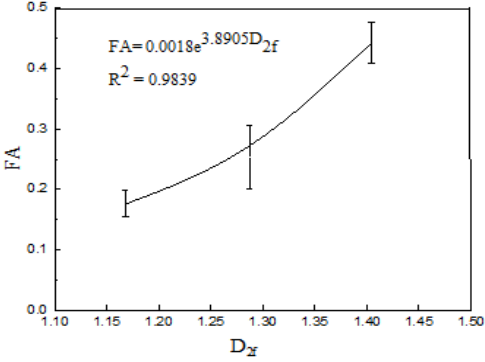
Figure 9. Influence of D 2f of flocs on FA.